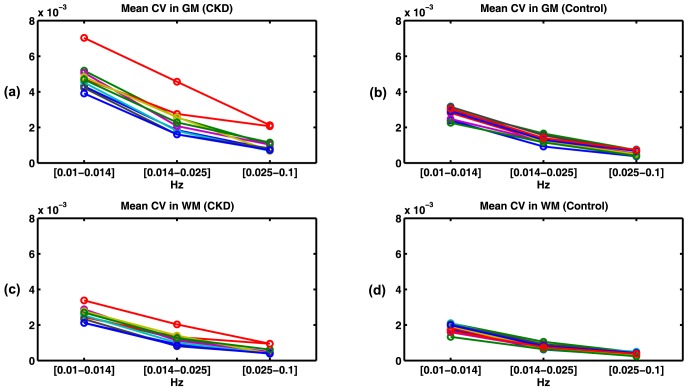
Mean CV of signal fluctuation in GM (a,b) and WM (c,d) in different frequency intervals ([0.01–0.014] Hz, [0.014–0.025] Hz and [0.025–0.1] Hz) for CKD (a,c) and control (b,d) cohorts.Lower frequency components have a larger contribution to the BOLD signal fluctuations.